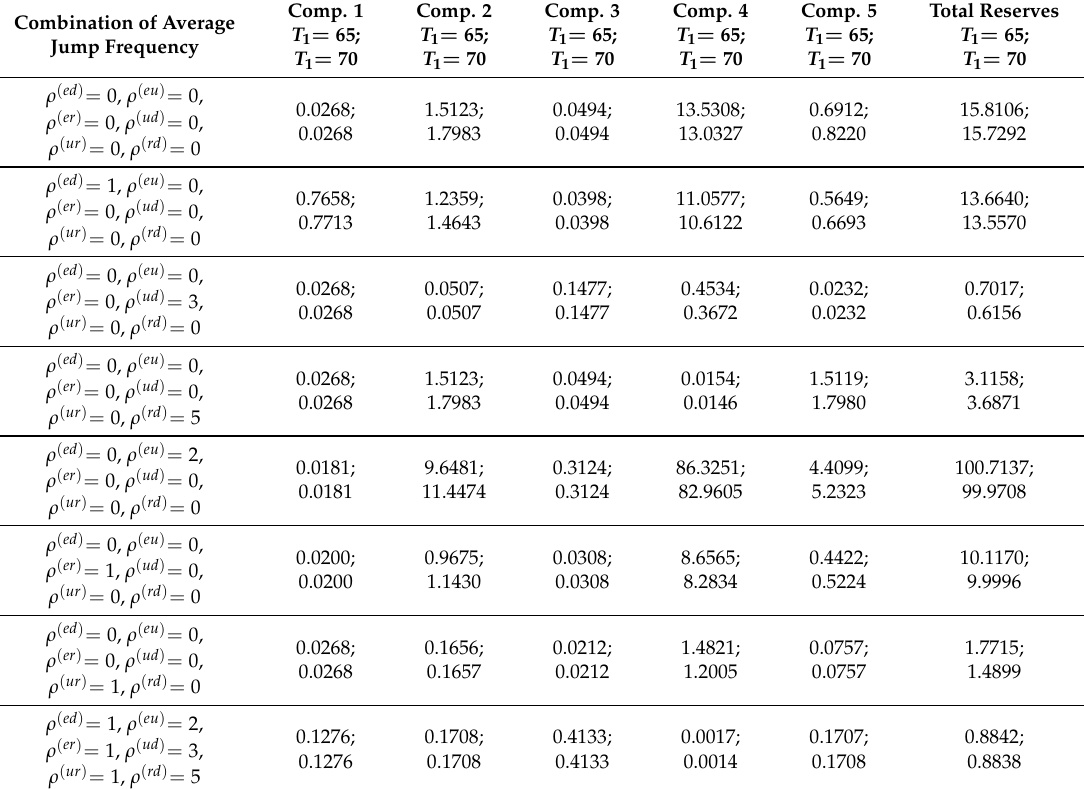
Table 2. Values of total reserves with various combinations of average jump frequency (rounded to 4 decimal places). The term Comp. denotes